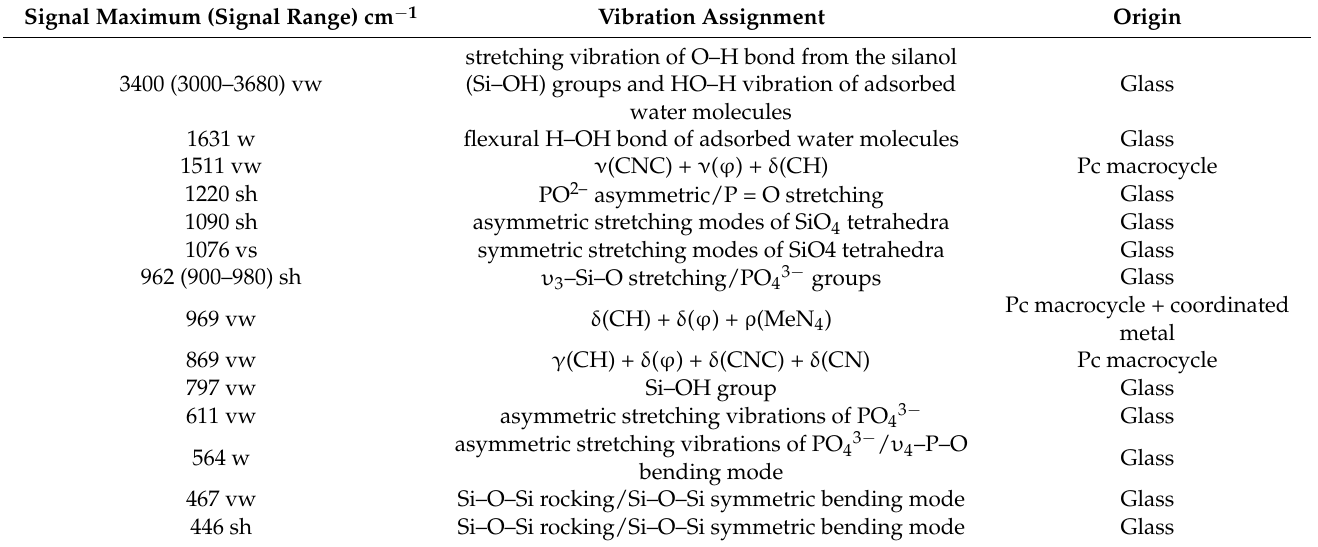
Table 1. FTIR spectrum signal